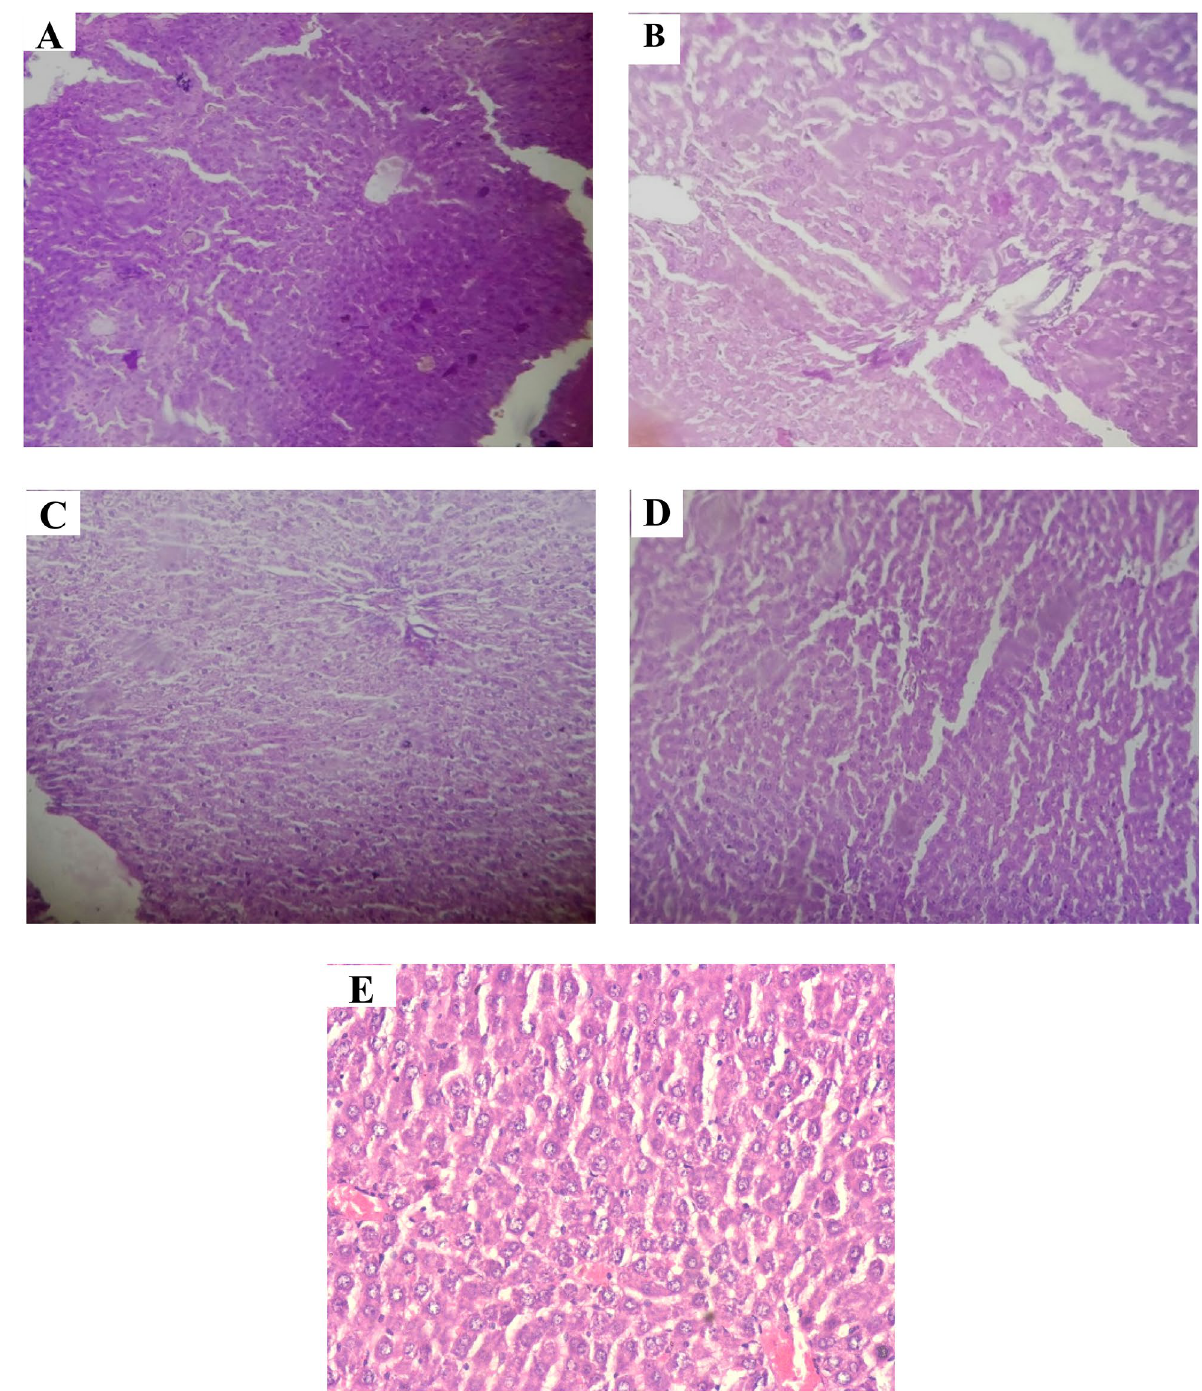
Fig. 5 Histopathological examination of hepatoprotective activity of Chlorzoxazone and Silymarin when administered along with Paracetamol (300 mg/kg). A (Control). B Represents the Liver Histology section of rats treated with Paracetamol; ballooning degeneration, vascular congestion, sinusoidal dilatation, Central vein (CV), and steatosis;(clear vacuoles contained lipid in life) were seen in Paracetamol treated group C , D Represents the Liver Histology section of rats treated with paracetamol and Chlorzoxazone 50 mg/kg & 100 mg/kg; E Represents the Liver Histology section of rats treated with paracetamol and silymarin 100 mg/kg. The images from C – E show a significant improvement in the hepatic markers with scattered cytoplasmic vacuolization indicating the hepatic protective property of Chlorzoxazone and